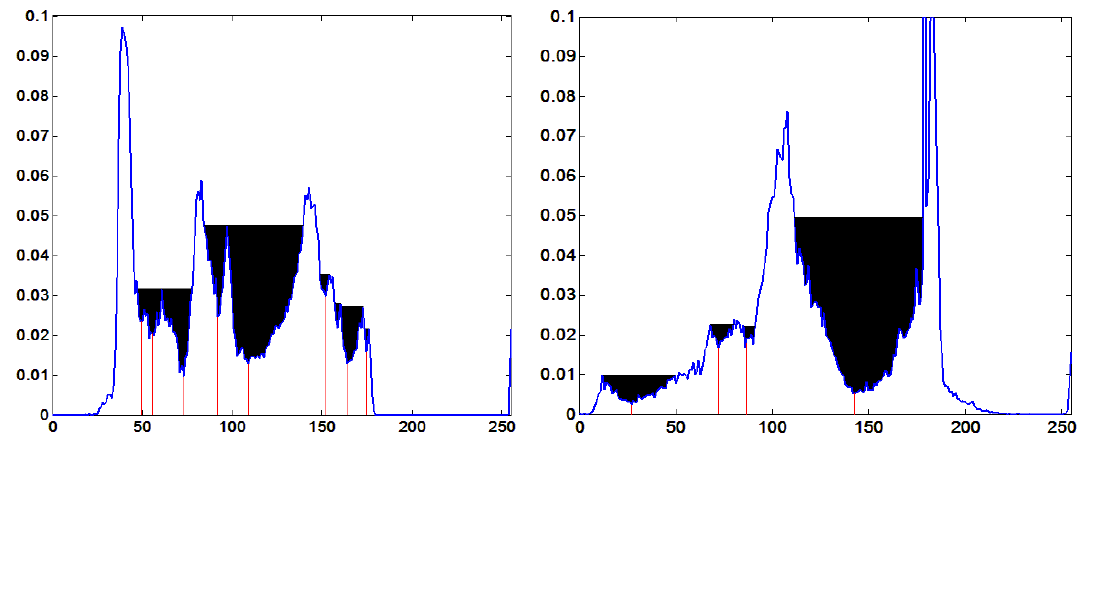
Figure 12. Water regions and thresholds of first row images in Figures 10 and 11,